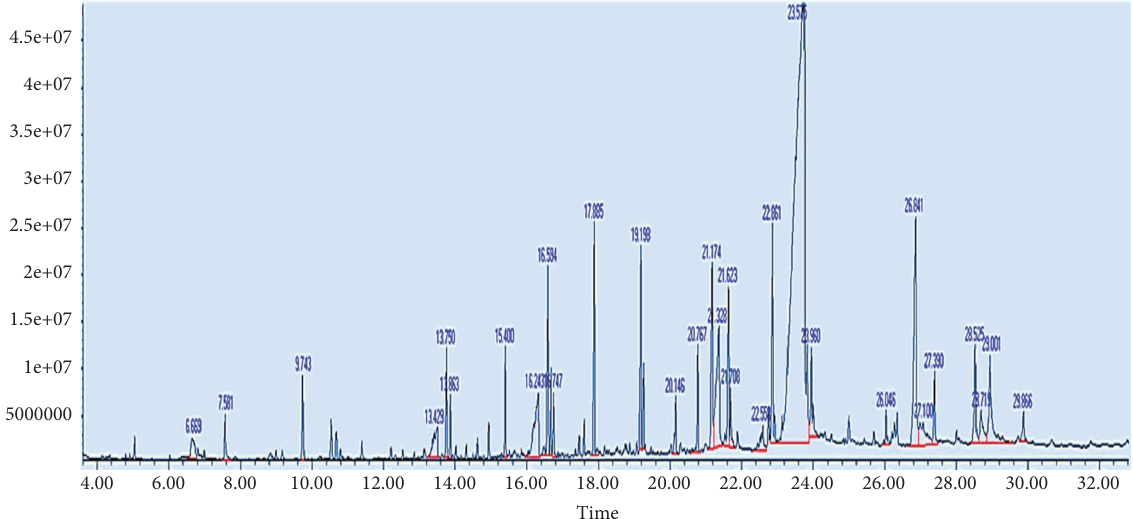
Figure 4: GC-MS chromatograph of crude extracellular ethyl acetate extract of Paecilomyces